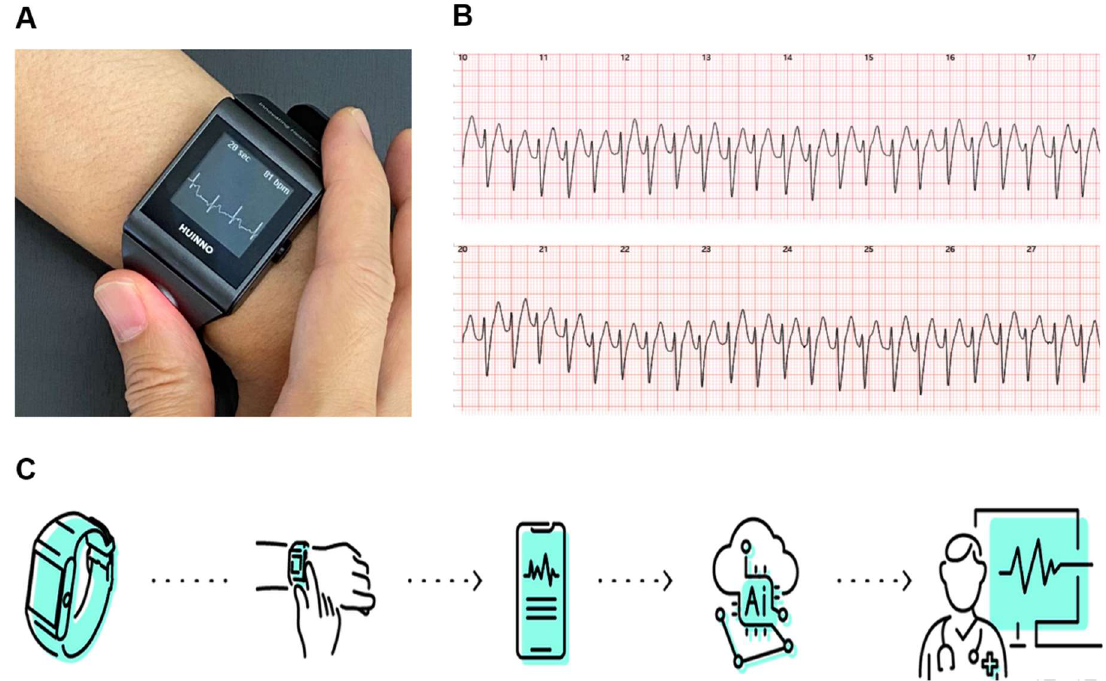
Figure 1. The watch-type ECG device (w-ECG): ( A ) Representative image of the w-ECG. ( B ) ECG recorded by the w-ECG. ( C ) Processing of the w-ECG. Recorded ECGs are sent to the centralized server and analyzed by an artificial intelligence-based algorithm. ECG: electrocardiography.